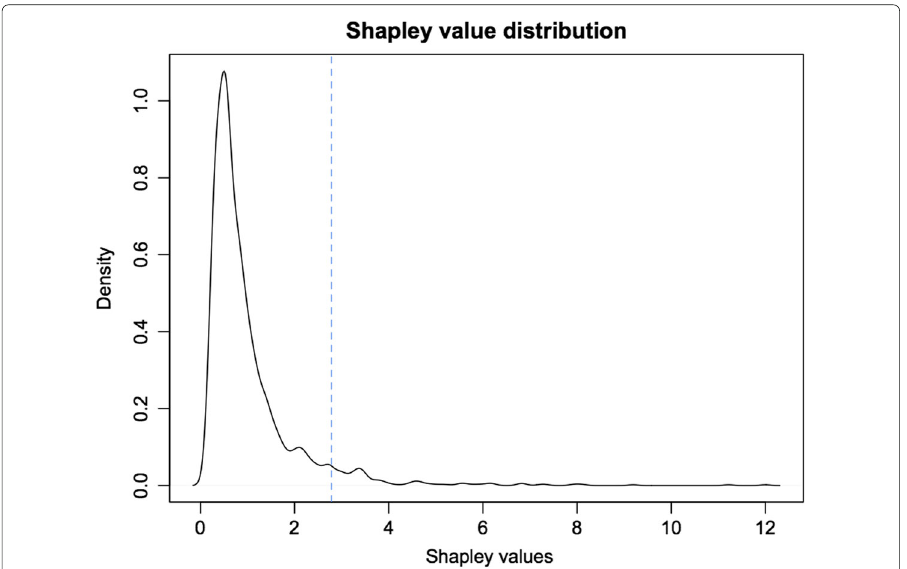
(i) the 108 genes selected by the Shapley value ρ are directly connected to 1412 genes. With the only exception of betweenness centrality (the 108 genes selected with the highest betweenness centrality are directly connected to 1423 genes), the other measures are much less effective in this sense: the genes selected by the degree centrality interact with 1062 genes, the ones by closeness centrality with 668 and the ones by eigenvector centrality with 383 genes.